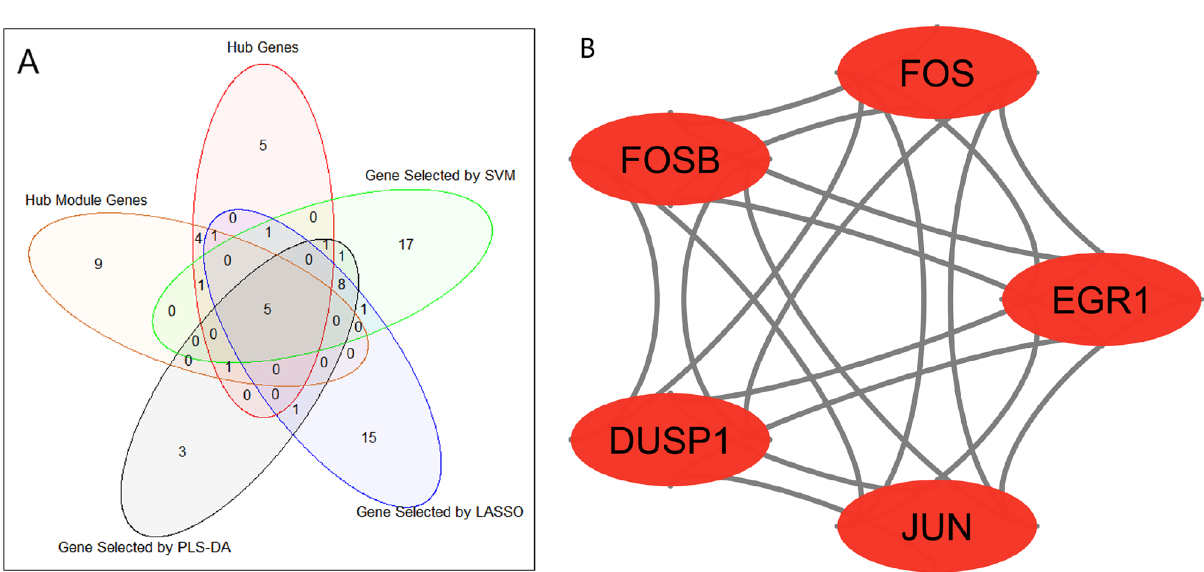
Figure 7. Identification and PPI analysis of key hub genes for IgAN patients. ( A ) Key candidate genes identification from hub module genes, computed from Cytohubba, SVM, LASSO, and PLS-DA. ( B ) PPI analysis of key five candidate